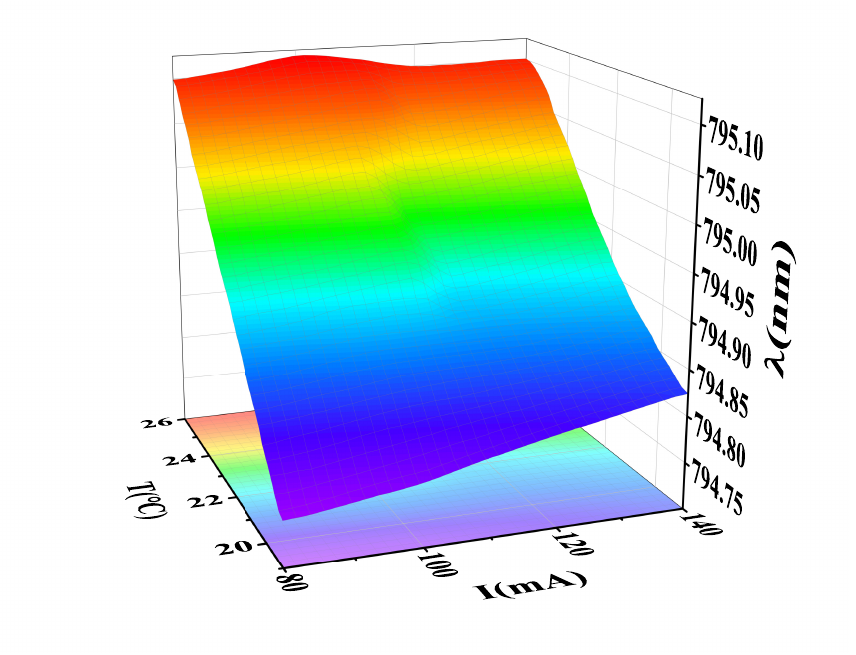
Figure 7. Power prediction of the GPR − P